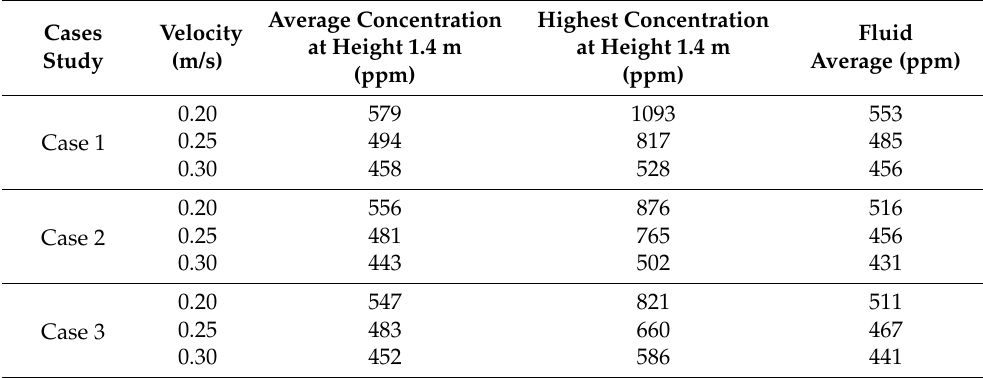
Table 3. Contamination concentration results at steady-state condition at 450 s.